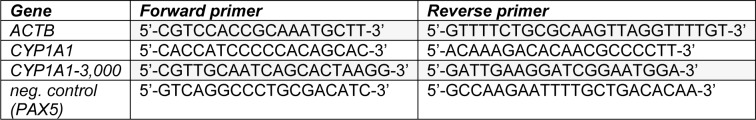
Primer sequences used for real-time quantitative PCR